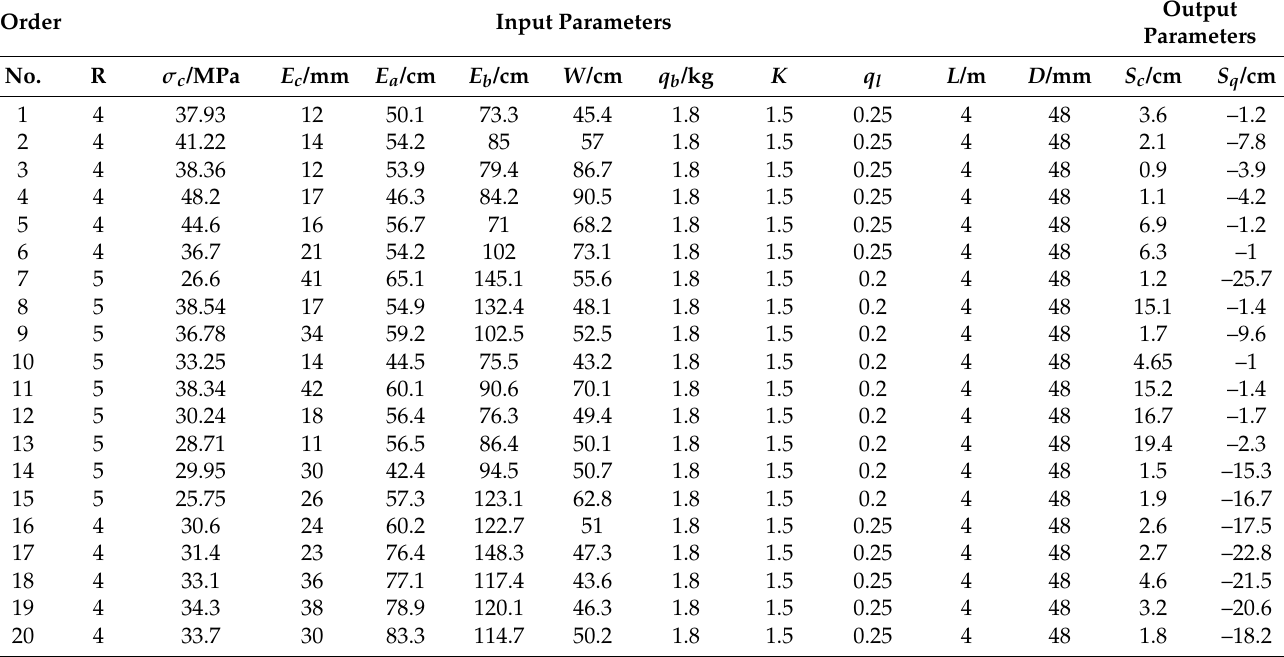
Table 2. Test sample parameter list.